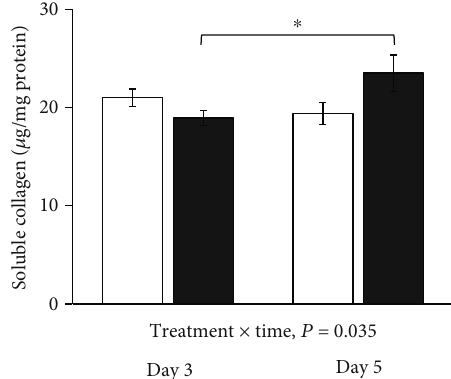
Figure 6: Soluble collagen protein levels in anastomotic wounds on days 3 and 5. Open bars: vehicle; fi lled bars: ZP1849. ∗ P < 0 : 05 . Mean ± SEM